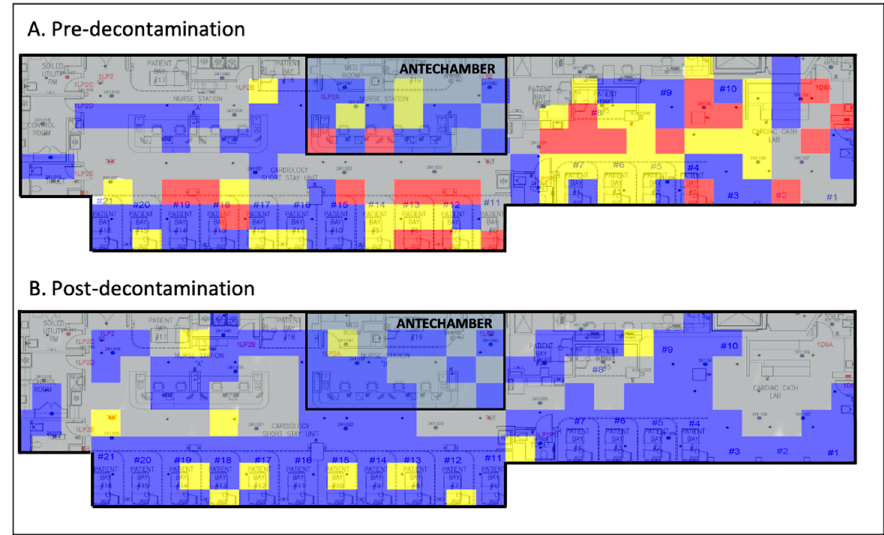
Figure 1. Viral heat map illustrating the efficacy of chemical decontamination of a COVID-19 ICU. Grey, no sample taken; blue, 0–1 viral copies/cm 2 ; yellow, 1–10 viral copies/cm 2 ; red, >100 viral copies/cm 2 . COVID-19, coronavirus disease 2019; ICU, intensive care unit.